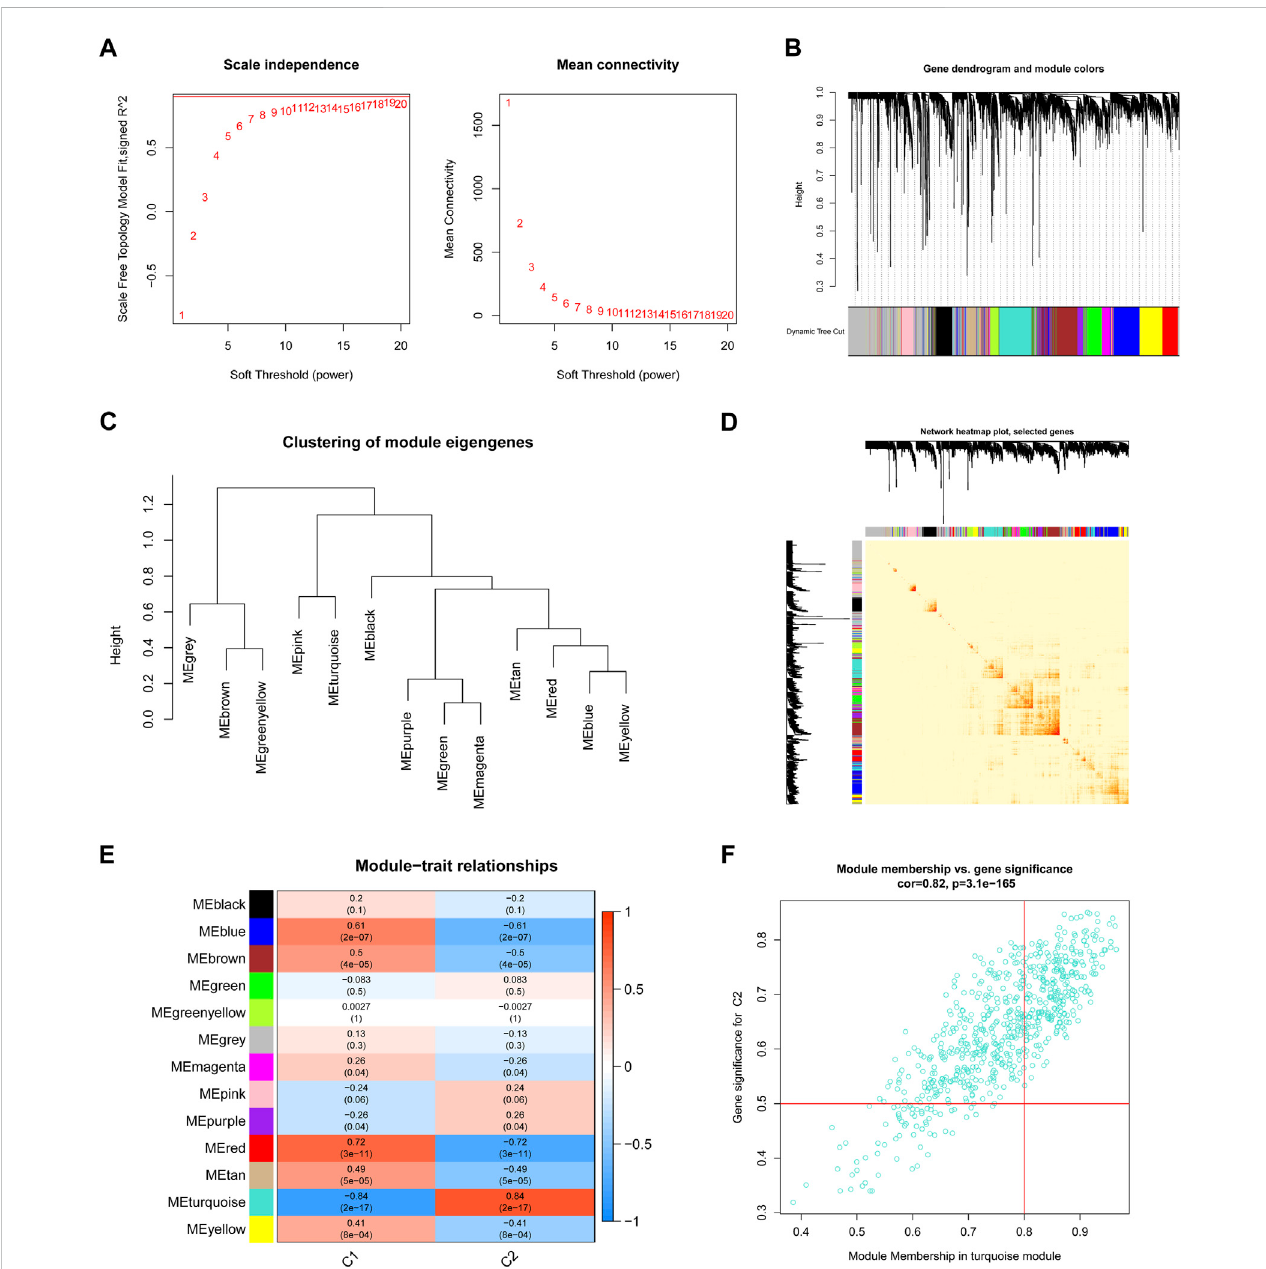
FIGURE 6 Co-expression network of DEGs between the two ER stress clusters. (A) The selection of soft threshold power. (B) Cluster tree dendrogram of co- expression modules. (C) Representative of clustering of module eigengenes. (D) Representative heatmap of the correlations among 13 modules. (E) Correlation analysis between module eigengenes and clinical status. (F) Scatter plot between module membership in turquoise module and the gene signi fi cance for cluster